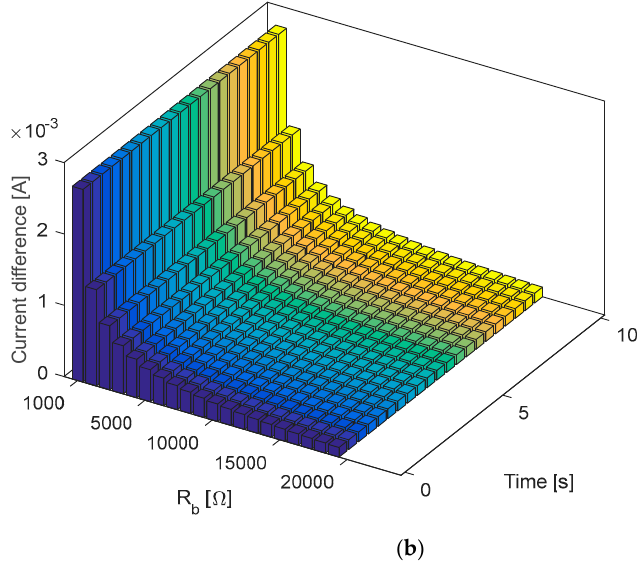
Figure 7. Differences in values of ( a ) voltages, and ( b ) currents, calculated using full expression derived in this study for large values of R b and the Calasan et al. method in [27], with infinite parallel resistance value, considering P = 50 W, and R = 0.58 m Ω .